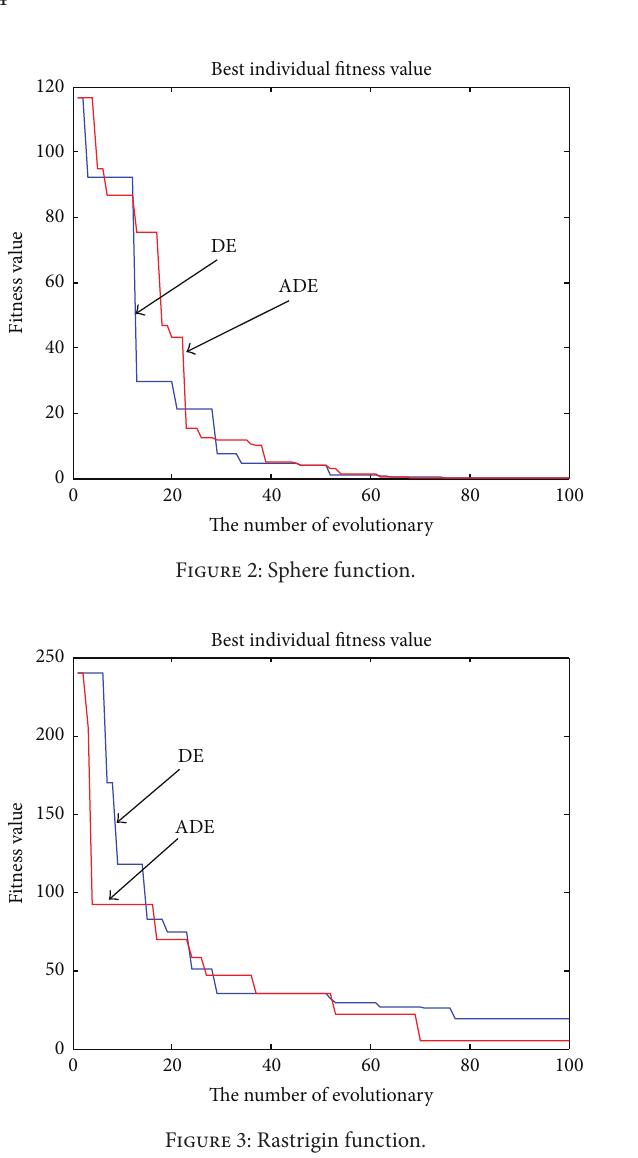
Figure 5: Ackley function.